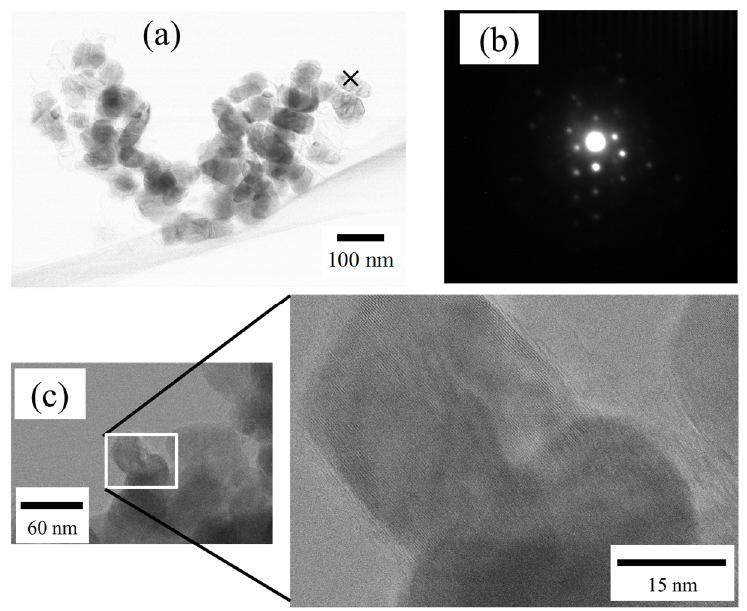
Figure 3. ( a ) Field Emission Scanning Transmission Electron Microscope (FE ‐ STEM) image (TE mode) and ( b ) Electron diffraction pattern of microwave ‐ treated sample (950 °C, 30 min). ( c ) FE ‐ STEM image of microwave ‐ treated sample (950 °C, 30 min) and its high resolution image.